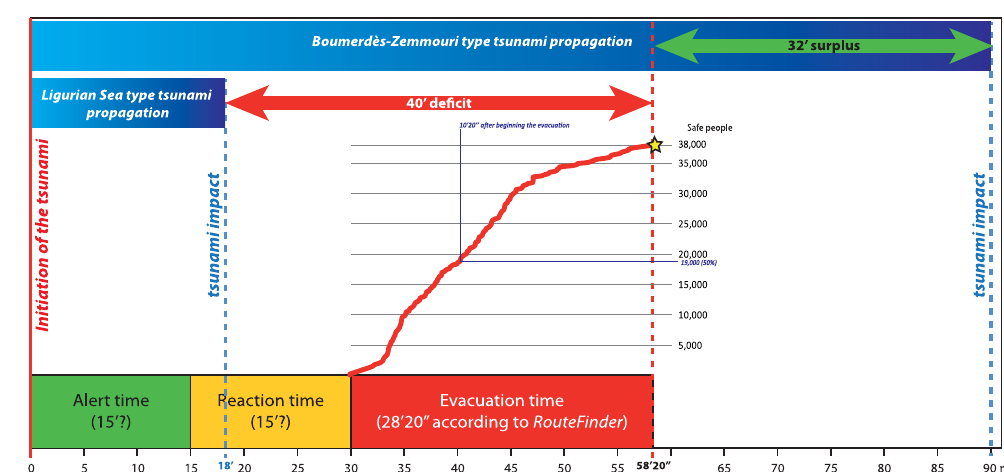
Fig. 10. Confrontation of the modelled accessibility curve for shelters vs. hazard scenarios: deficit and surplus for crisis management.